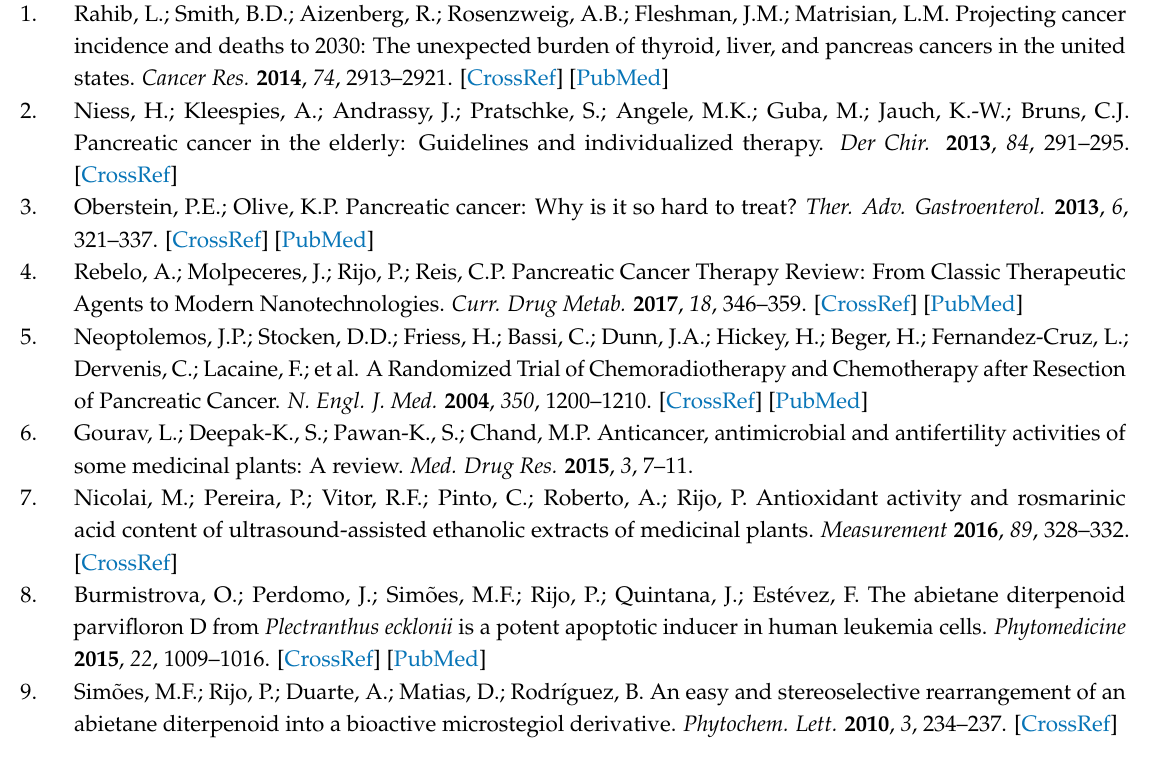
Table S1: NMR data of PvD, (CDCl 3 , 1 H 400 MHz, 13 C 100 MHz; δ in ppm, J in Hz); Table S2: Significant assignments observed on HMBC experiment for PvD and Table S3: IC 50 ( µ M) values in different time points, 24 h and 48 h, of different cell lines—cytotoxicity